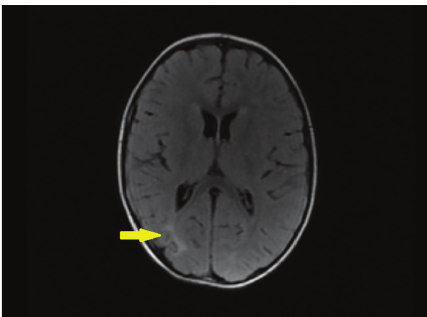
Figure 1: Brain MRI showed a subcortical increased signal in the right occipital lobe on T2-weighted image.